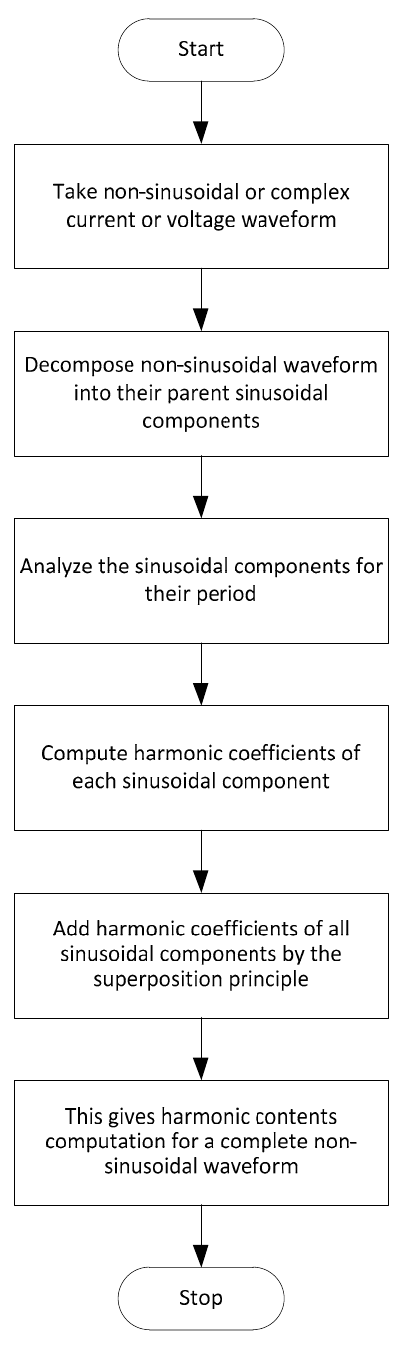
Figure 1. Flow chart of the pulse selective approach (PSA).